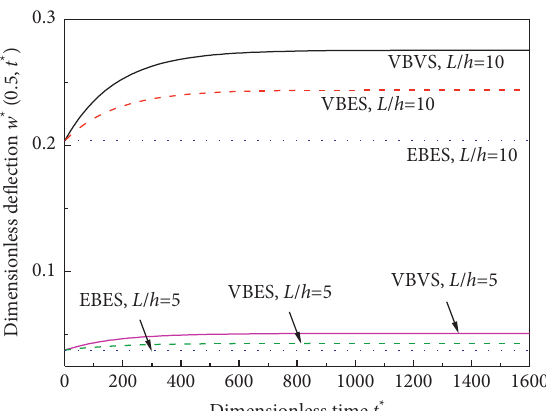
Figure 7: Response of dimensionless midspan deflection w ∗ (0.5, t ∗ ) versus dimensionless time t ∗ of the viscoelastic beams with different cracked models.